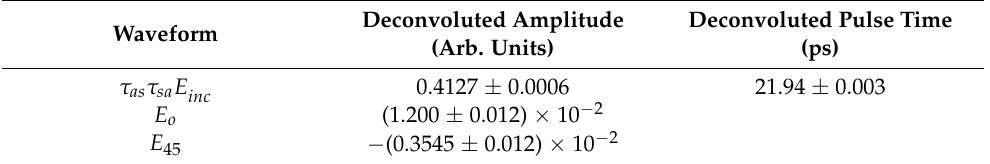
Table 1. Extracted amplitudes and arrival times (in ps) for the various deconvoluted time-domain waveforms of Figure 3. The deconvolved pulse time is measured relative to the arrival time of E inc . Deconvoluted Amplitude Waveform (Arb.